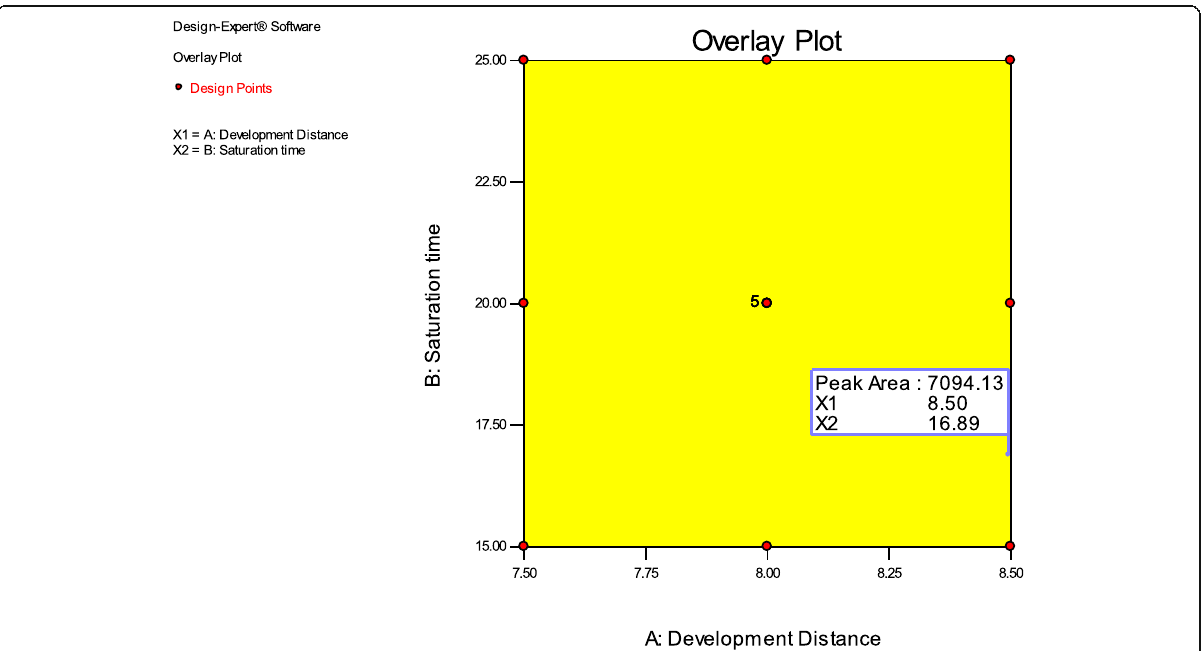
Fig. 4 Overlay plot of the face-centered CCD showing optimum chromatographic conditions